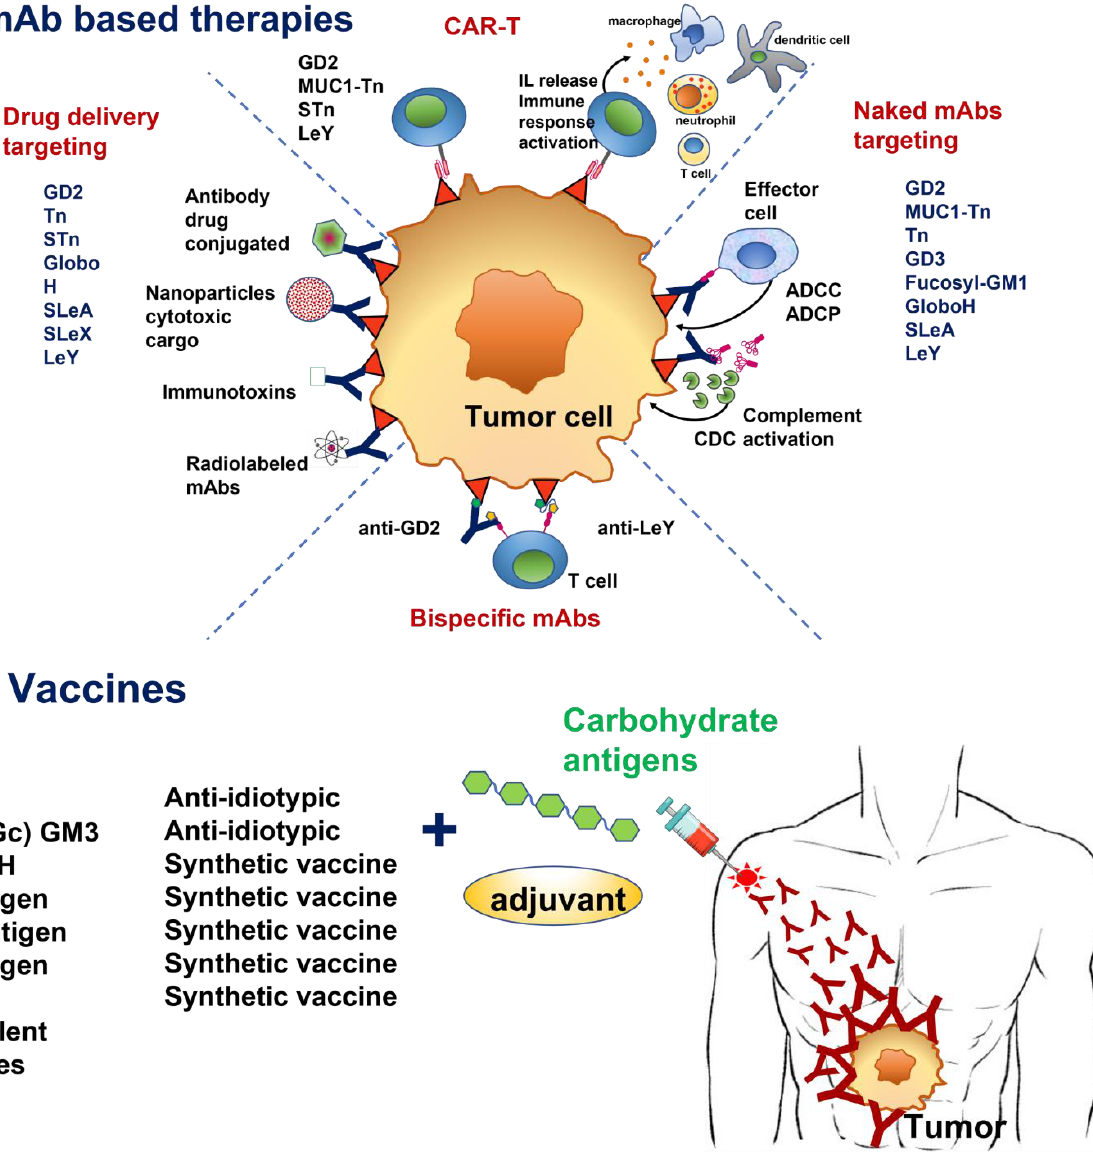
Figure 1. Schematic representation of antitumor strategies based in antibodies and vaccines target- ing TACAs (Tumor Associated Carbohydrate Antigens). mAbs (monoclonal antibodies); CAR-T (Chimeric antigen receptor-T); STn (sialyl Tn); SLeA (sialyl Lewis A); SLeX (sialyl Lewis X); LeY (Lewis Y); ADCC (Antibody-Dependent Cell-mediated Cytotoxicity); ADCP (Antibody-Dependent Cellular Phagocytosis); CDC (complement-dependent cytotoxicity).